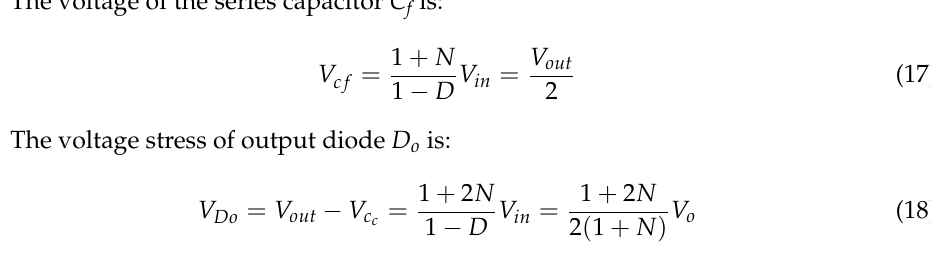
This is same with the output diode voltage